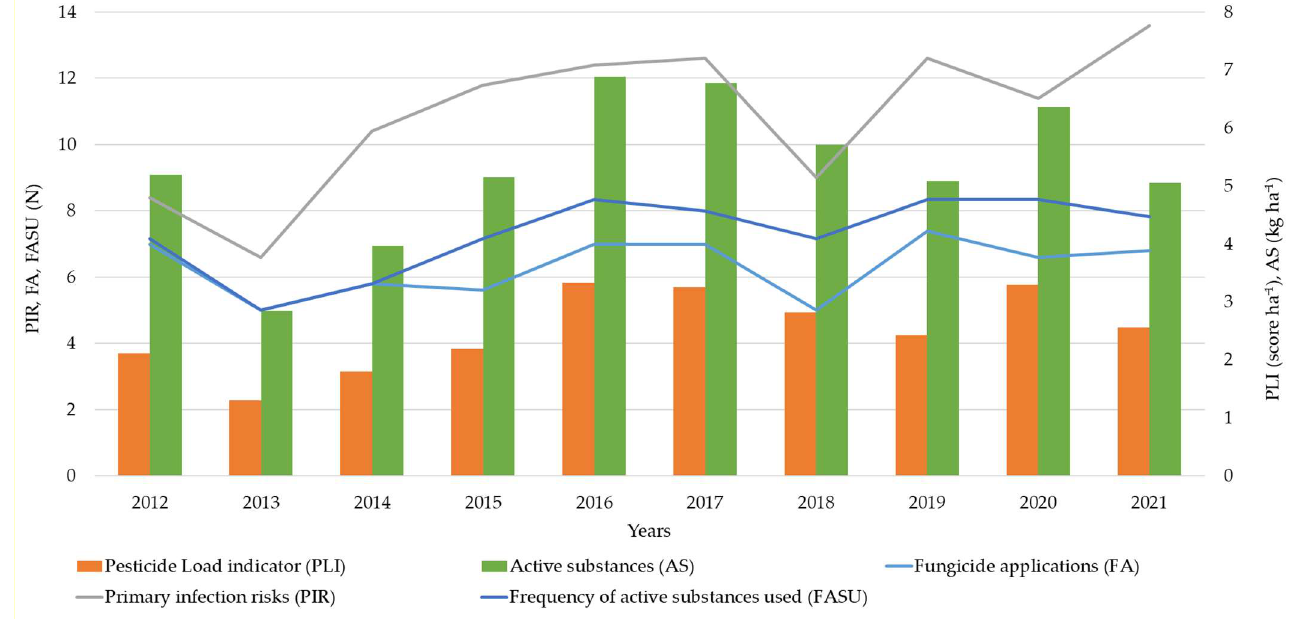
Figure 1. Average number (N) of primary infection risks (PIR), fungicides applications (FA), fre- quency of active substances used (FASU), Pesticide Load Indicator (PLI) score and quantity of active substances per hectare referred to the six farms considered during 2012–2021 apple-growing sea-